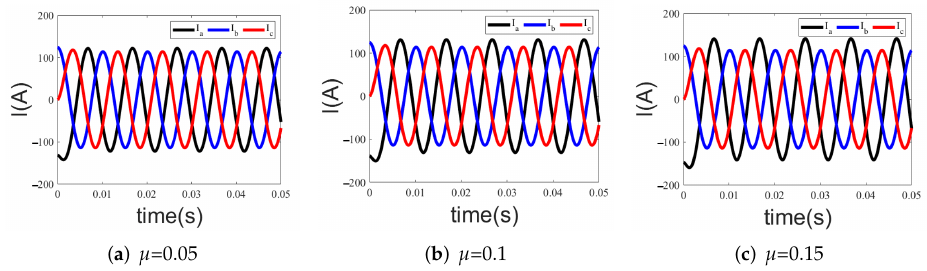
Figure 6. Three phase current when there is an A − phase fault. ( a ) µ = 0.05 ( b ) µ = 0.1 ( c ) µ =